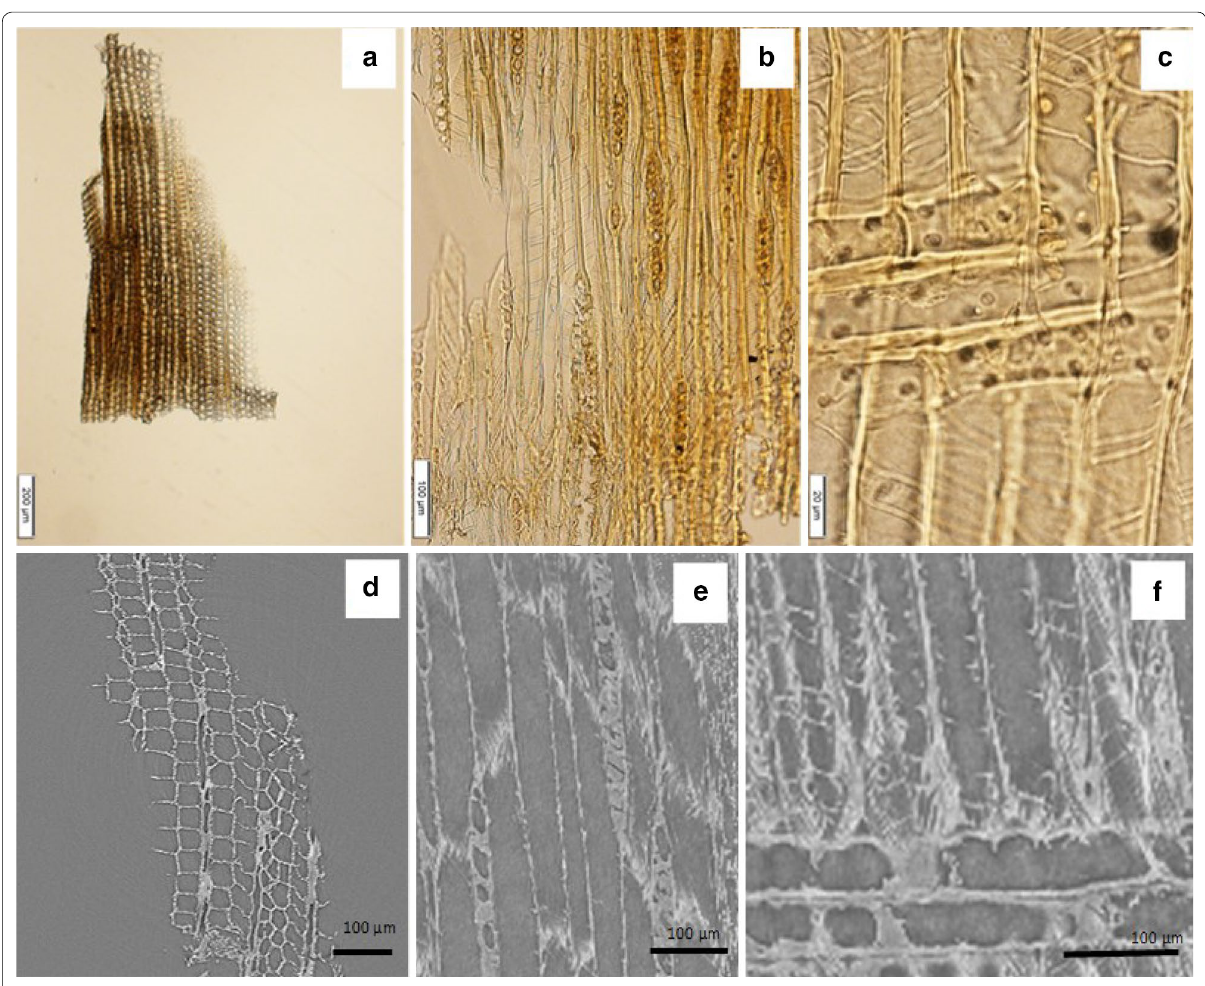
Fig. 3 Micrographs of female deity 3 (b in Table 1) and pseudo-sections constructed from the SRX-ray μCT dataset from SPring-8 for Female 4 ( c in Table 1). a , d cross-section, b , e tangential section and c , f radial